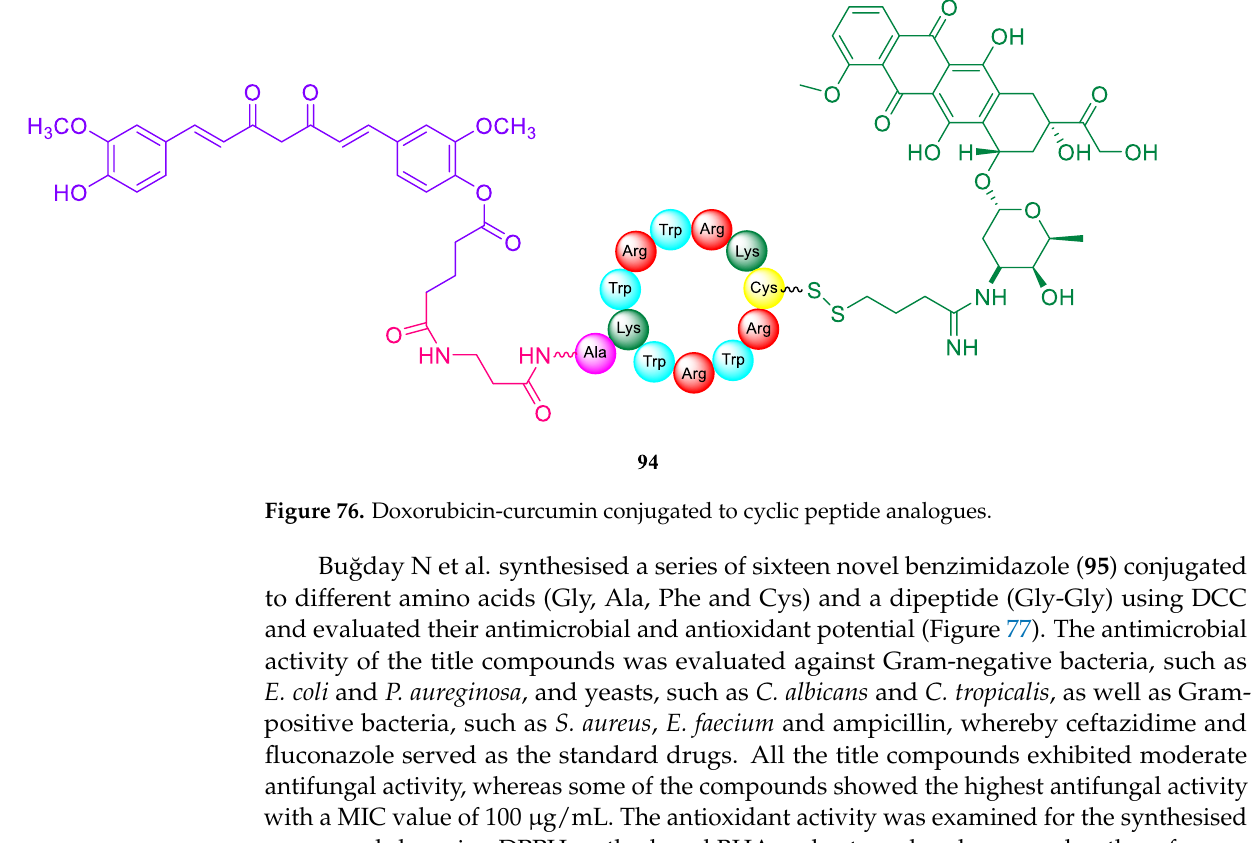
Figure 77. Amino acid/Peptides conjugated to benzimidazole derivatives. Bánóczi Z et al. synthesised a series of vindoline analogues ( 96 , 97 ) conjugated to oli- goarginine (tetrapeptides, hexapeptides, or octapeptides) and evaluated their antitumor activity in vivo and in vitro (Figure 78). The vindoline are the major alkaloids in plants and were first extracted from the leaves of Catharanthus roseus . N-terminal of octa-arginine